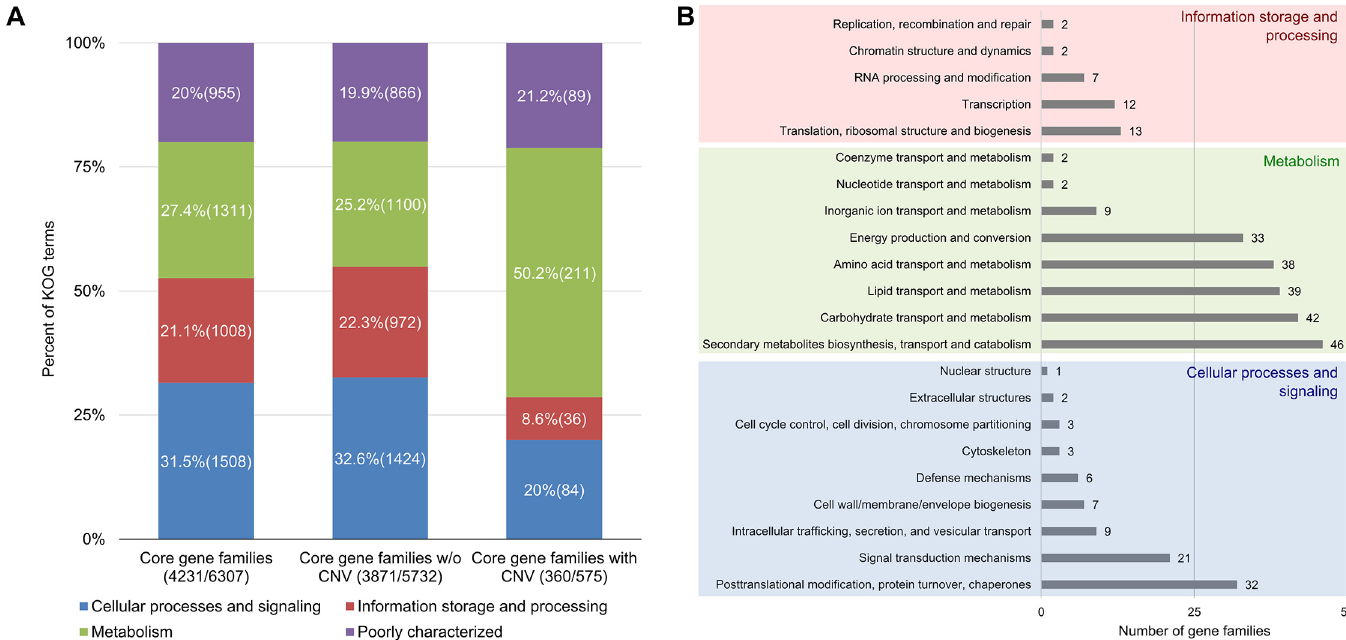
Fig 5. Distribution of KOG annotation profiles in core gene families with or without copy number variation (CNV) among Pseudocercospora musae , Pseudocercospora eumusae , and Pseudocercospora fijiensis . (A) Plotted in the different segments of the stacked bars is the percent of KOG terms assigned to core gene families (column 1), core gene families without (w/o) copy number variation (CNV) (column 2), and the core gene families with CNV (column 3), for each of the main functional categories of KOG (Cellular processes and signaling: blue; Information storage and processing: red; Metabolism: green; and Poorly characterized: purple). The number in the parenthesis of each segment in the columns refers to the number of KOG terms assigned to the gene families for each specific functional category of KOG. The first number in the X-axis label of each comparison refers to the total number of gene families with assigned KOG terms, whereas the second number refers to the total number of gene families in each comparison compartment. A high fraction (211, 50.2%) of the total number of 420 KOG terms that were collectivity assigned to gene families with CNV was ascribed to metabolism. (B) The number of gene families with CNV assigned to each subcategory of KOG. A high number of gene families (46) is associated with biosynthesis of secondary metabolites, transoport and catabolism, as well as carbohydrate transport and metabolism (42), lipid transport and metabolism (39), and amino acid transport and metabolism (38). Note that because some gene families receiving KOG annotations could be assigned to more than one functional categories of KOG, the number of KOG terms in this case is equivalent to the number of gene families.